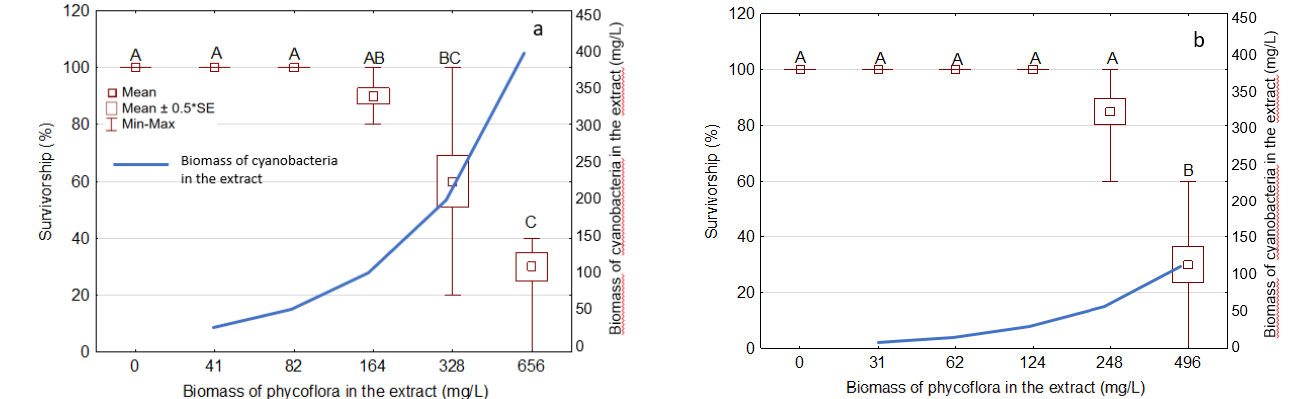
Figure 5. The influence of the Phormidium extract ( a ) and the Oscillatoria extract ( b ) on the survivor- ship of D. magna after 48 h exposure (mean ± SE; n = 4, 0 = controls). The survivorship of organisms in controls was set as 100%. Uppercase letters (A, B, C) point to statistically significant differences between treatments (ANOVA, Tukey’s test, p < 0.05). Table 3. Toxicity (48 h LC 50 ) of extracts to D. magna , determined on the basis of the concentration of the total phycoflora biomass and cyanobacterial biomass present in the extracts (mean ± SD; n = 4).